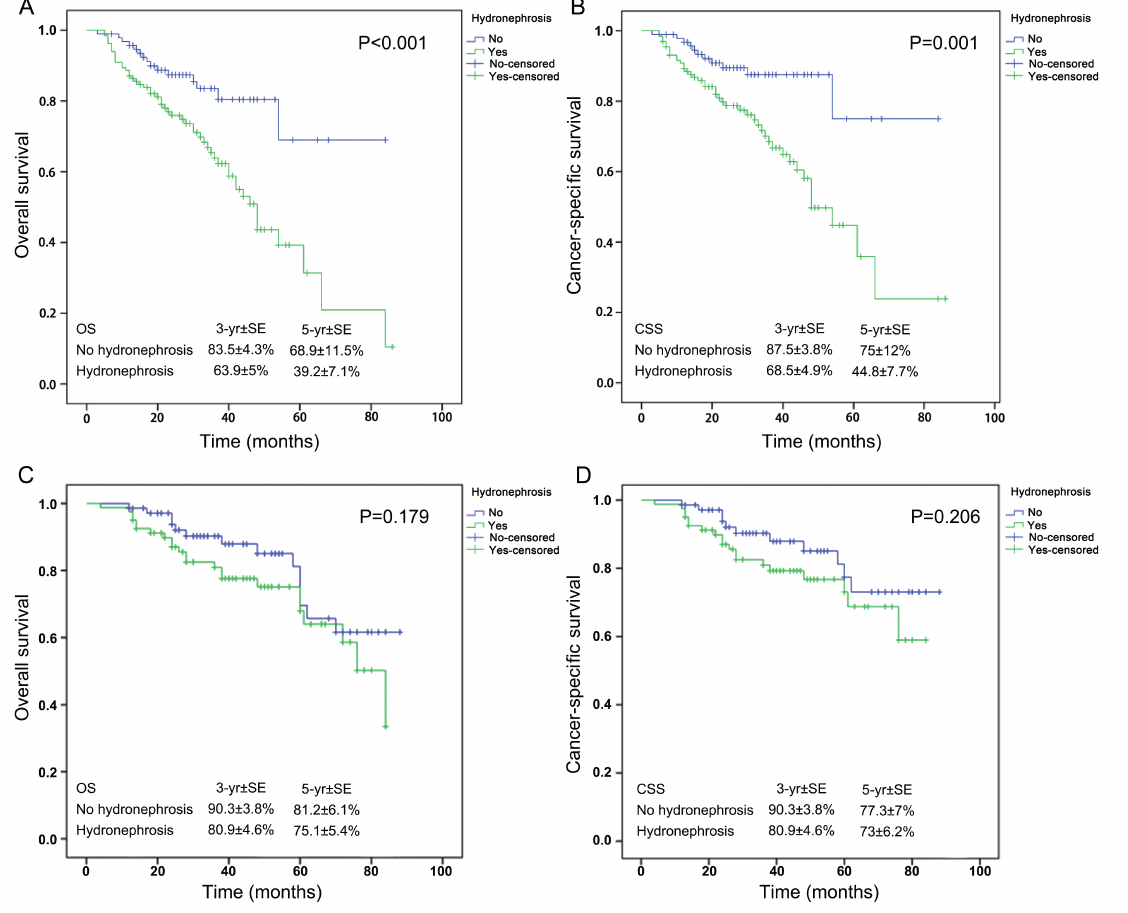
Figure 1 - Survival of patients with UTUC. (A) Overall survival in 226 patients with high-grade UTUC. (B) Cancer-specific survival in 226 patients with high-grade UTUC. (C) Overall survival in 151 patients with low-grade UTUC. (D) Cancer-specific survival in 151 patients with low-grade UTUC. CSS, cancer-specific survival; OS, overall survival; SE, standard error; UTUC, upper tract urothelial